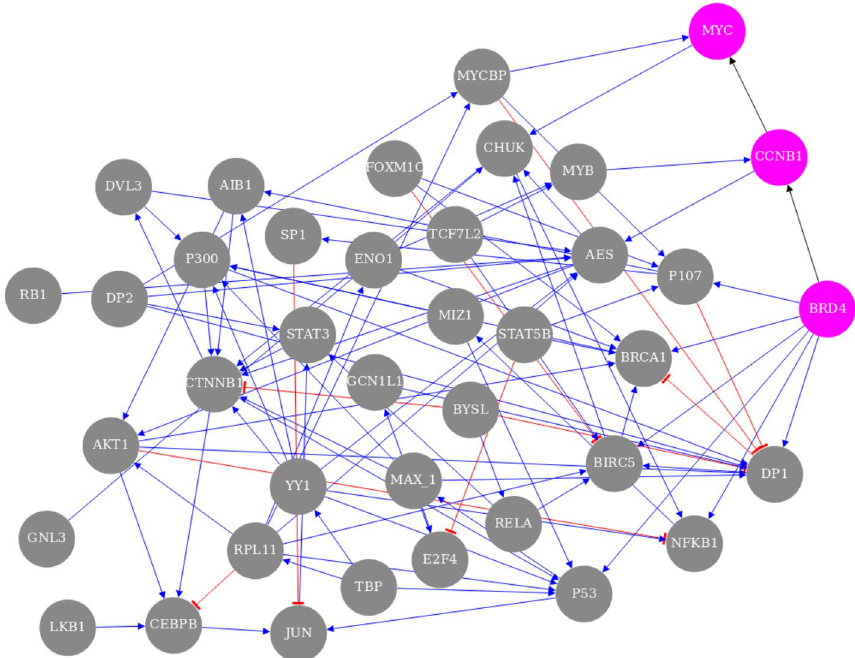
Figure 4. The overall best performing GRN. Each of the 125 links has at least 97.5% bootstrap support, and the sparsity is 3.2 links/gene among its 39 genes. The 39 self links are not shown. The genes involved in the external validation experiment, BDR4, CCNB1, and MYC, are highlighted pink. Blue links reflect up regulation while red reflect negative down regulation. The visualization was made by the provided shiny